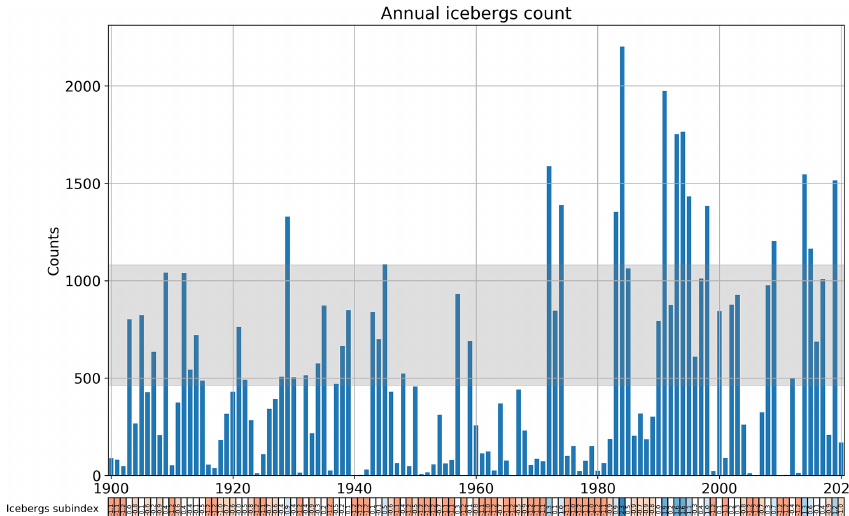
Figure 5. Annual iceberg count crossing south of 48 ◦ N on the northern Grand Bank. The shaded area corresponds to the 1991–2020 average ± 0 . 5SD. The normalized anomaly of this time series is provided below the main panel under the form of a colour-coded scorecard. Here negative anomalies are red (generally corresponding to warmer conditions) and positive anomalies blue. This time series is one component of the NL climate index.